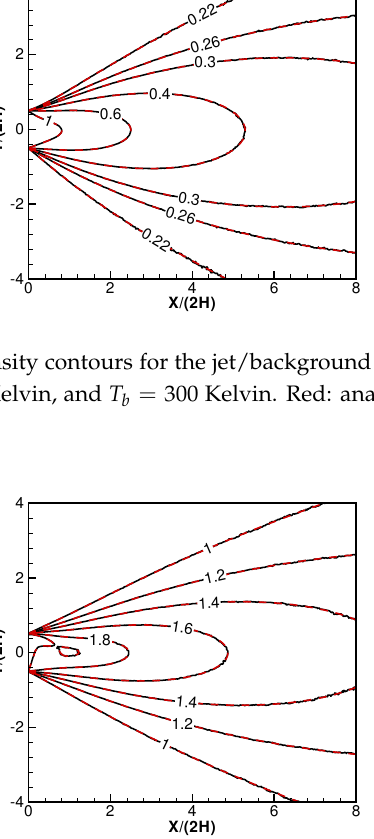
Figure 4. Nondimensional U-velocity component contours for the jet/background mixture, n b / n 0 = 0.2, S 0 = 2.0, α 0 = 45 ◦ , S b = 1.0, T 0 = 200 Kelvin, and T b = 300 Kelvin. Red: analytical, black: DSMC.